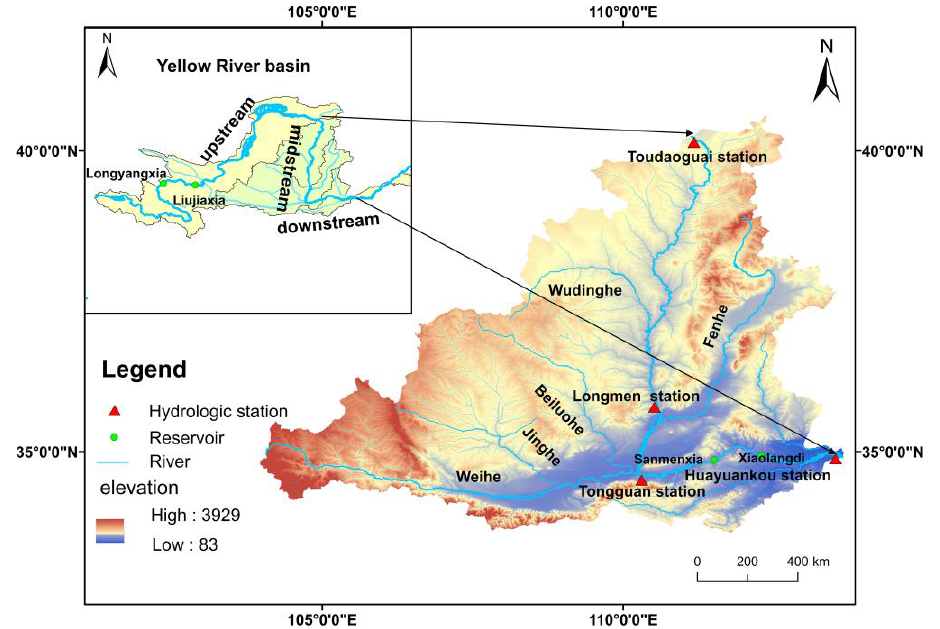
Figure 1. Schematic diagram of the middle reaches of the Yellow River.